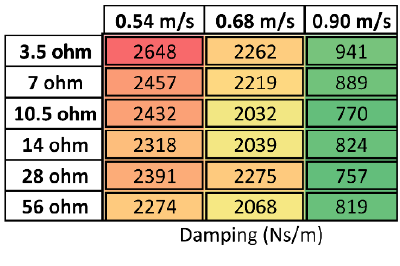
Figure 5. Estimated loss damping values for a sweep of velocity and load values. Higher speeds produced lower estimated damping